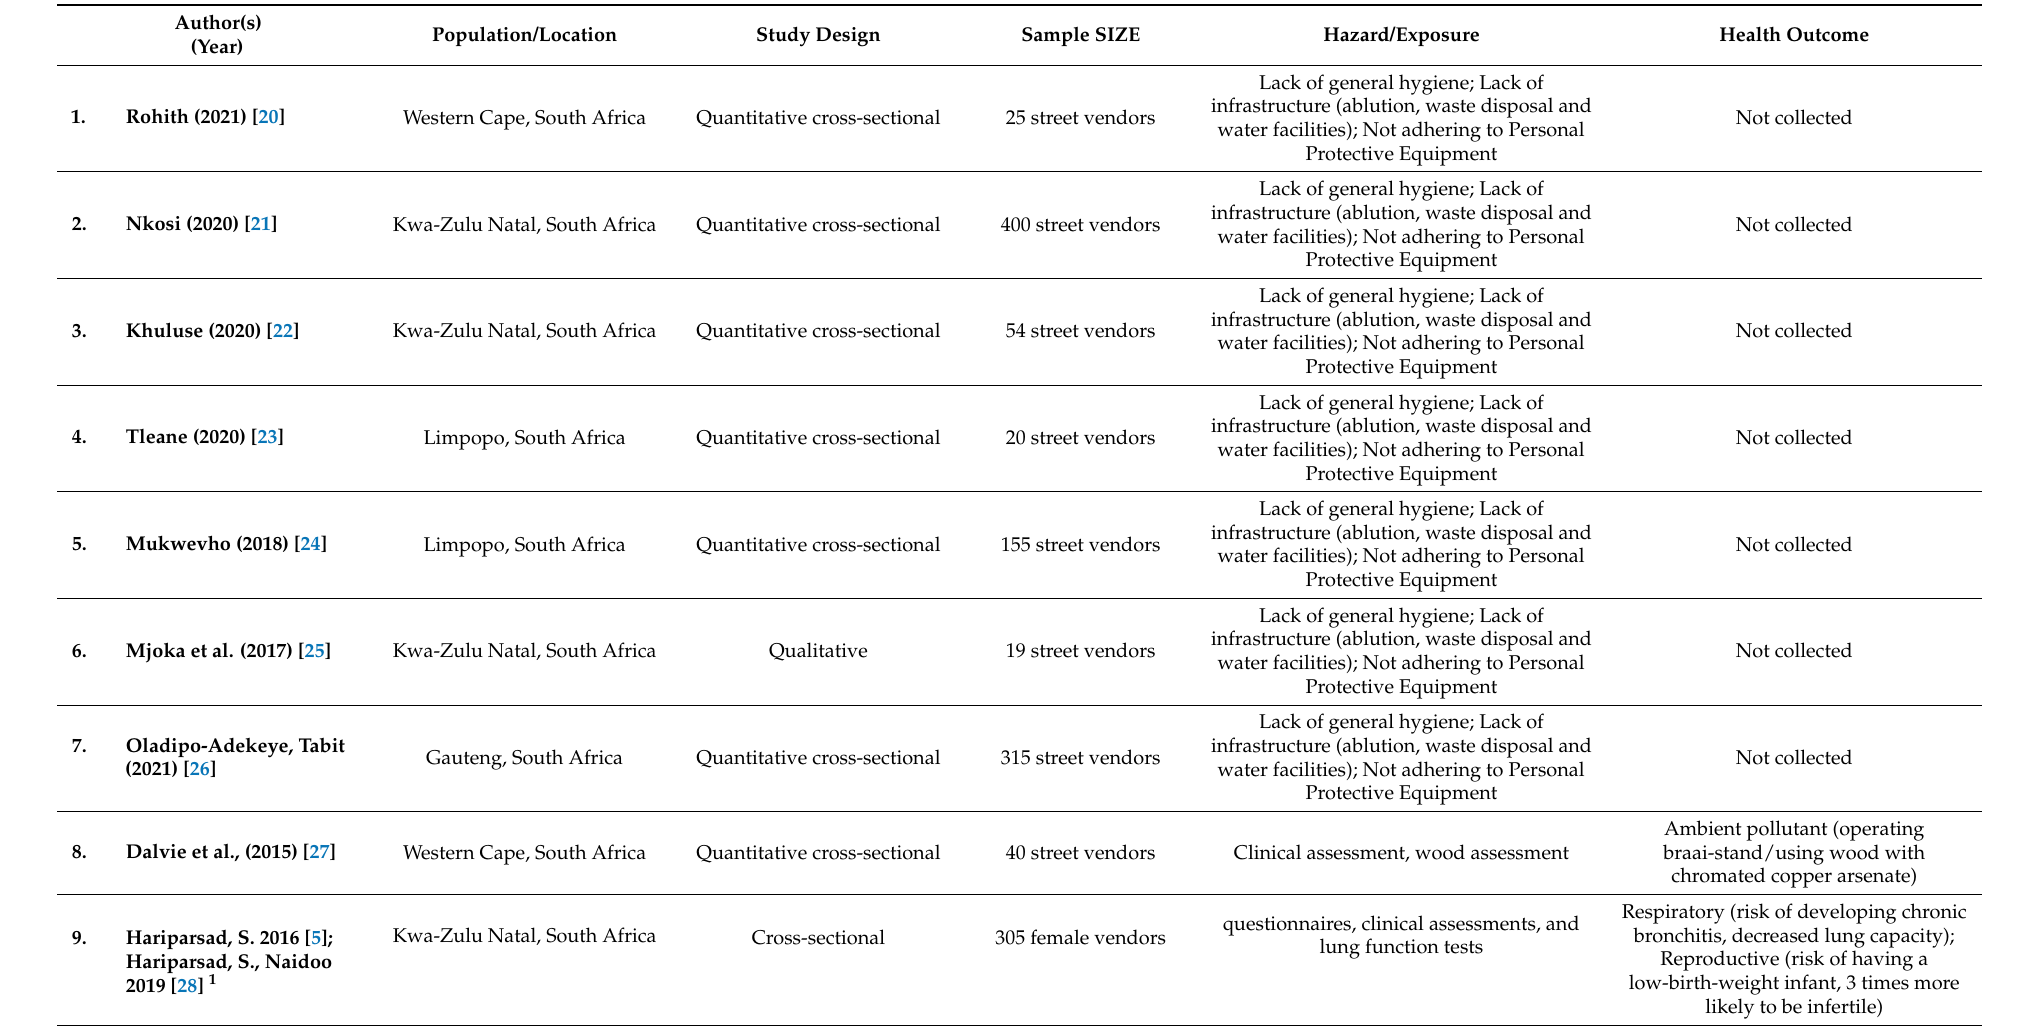
Table 2. Environmental and occupational exposures of informal street vendors and their associated health